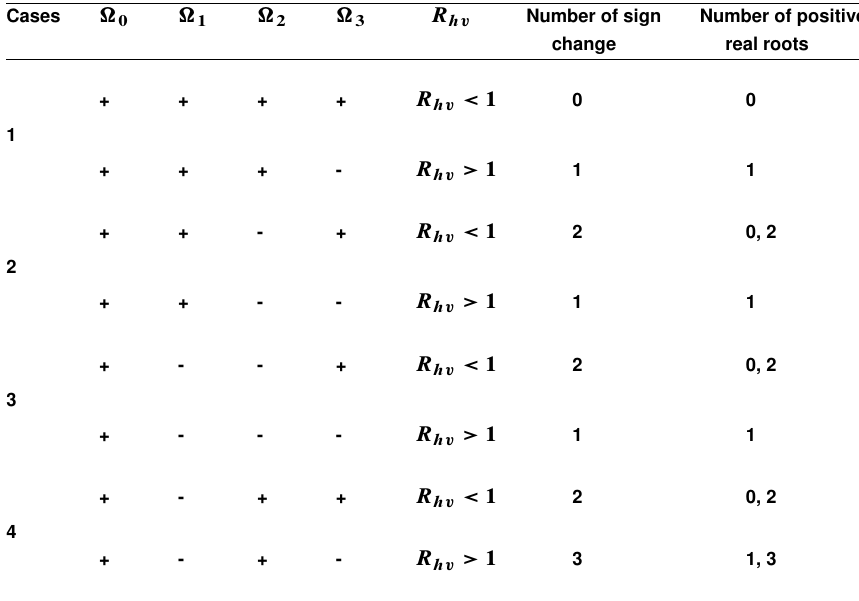
Table 1. Number of possible positive real roots of P.ˇ (cid:3) m / for R hv > 1 and R hv < 1